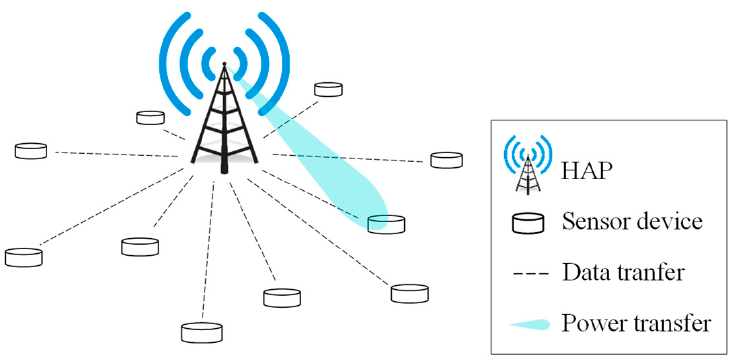
Figure 1. System architecture of TSCH multiple slotframe scheduling (TMSS).